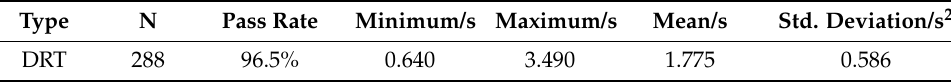
Table 3. The statistical description table of experimental data.